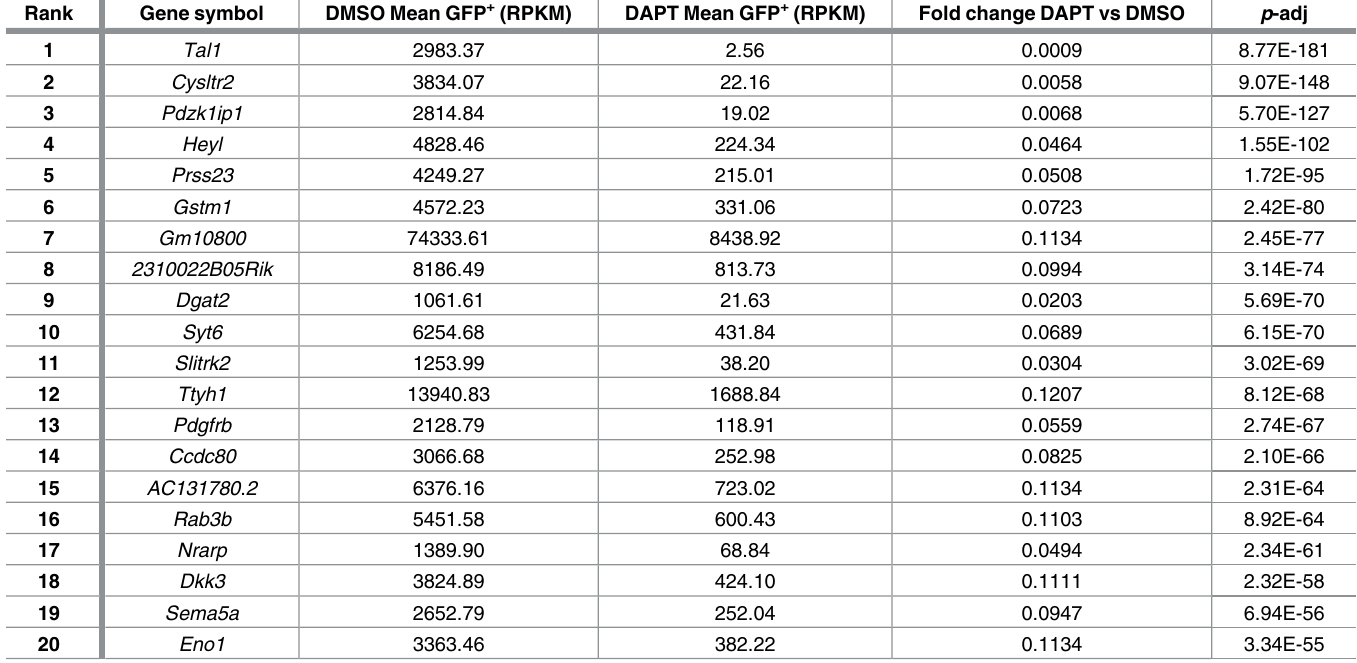
Table 9. Top 20 down-regulated genes after DAPT treatment in P0 Lfng-GFP + cells.